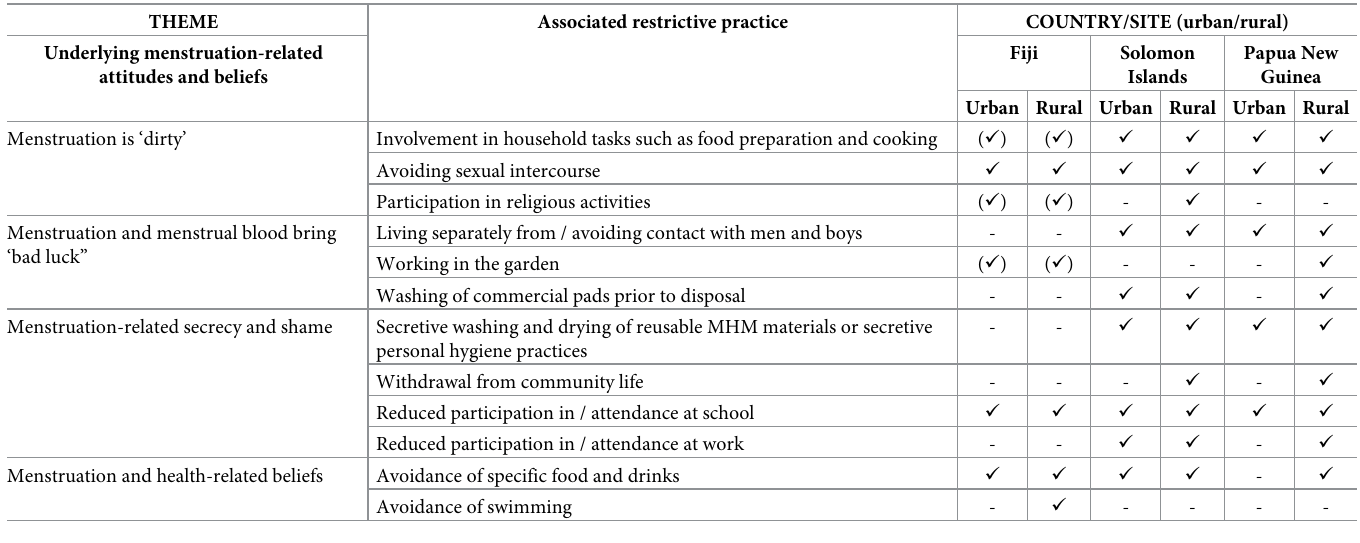
Table 2. Overview of main themes identified and the associated restrictive practices reported by country and site (urban/rural).